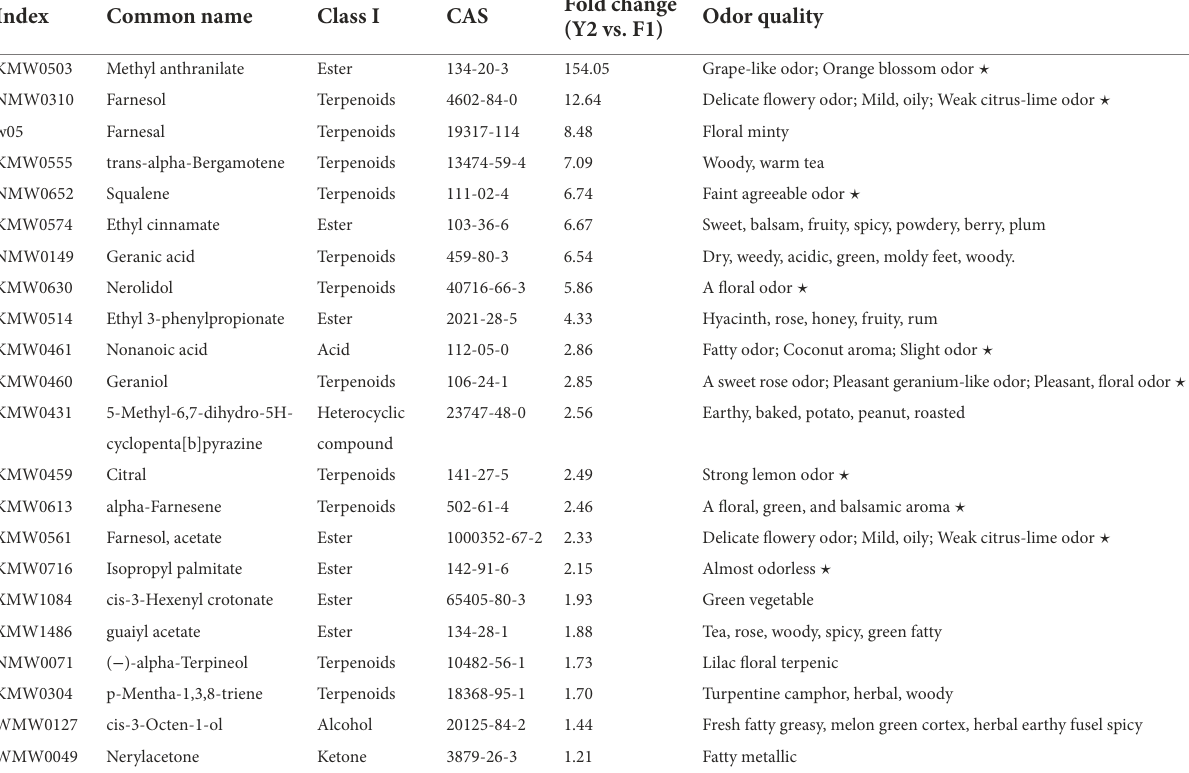
TABLE 1 Odorants that were differentially accumulated in ‘Yujin2’ compared to